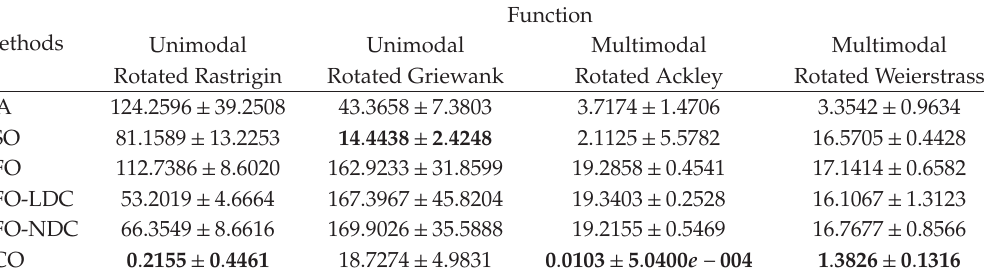
Table 4: Experimental results on benchmark functions f 9 ∼ f 12 (cid:3) 15-D (cid:4)